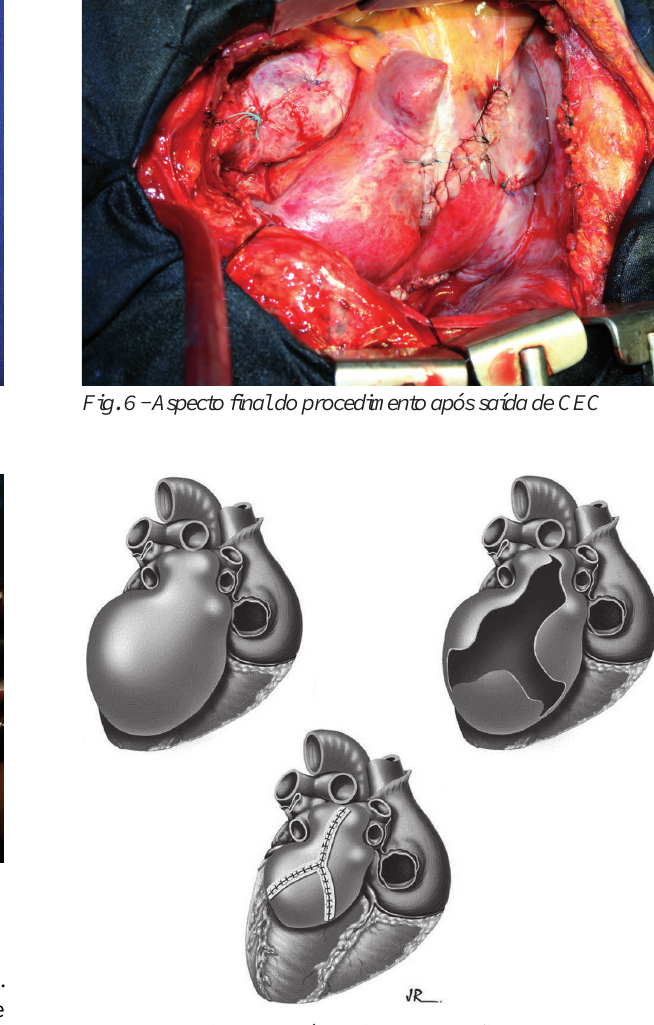
acompanhamento. O diâmetro médio do AE foi reduzido